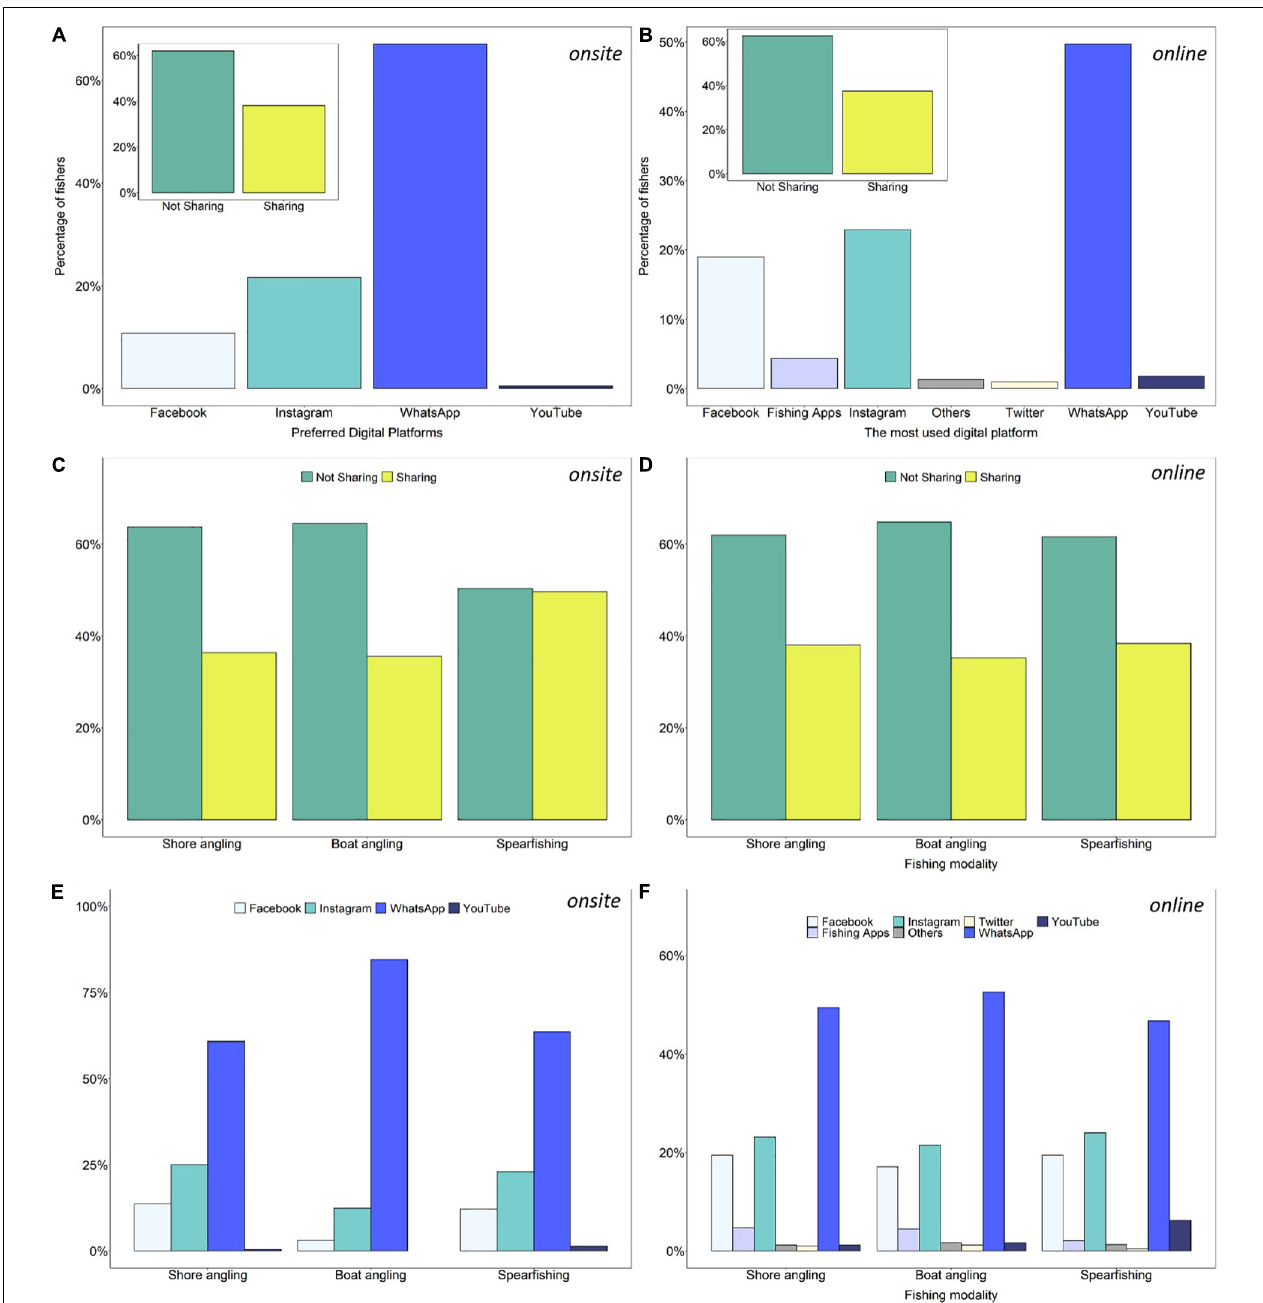
FIGURE 3 | Percentage of sharers using different digital platforms ( A for onsite and B for online surveys). The inlets in (A,B) represent the total proportion of sharers and non-sharers. Proportion of sharers for each fishing modality ( C for onsite and D for online surveys). Use of different digital platforms for each fishing modality ( E for onsite and F for online